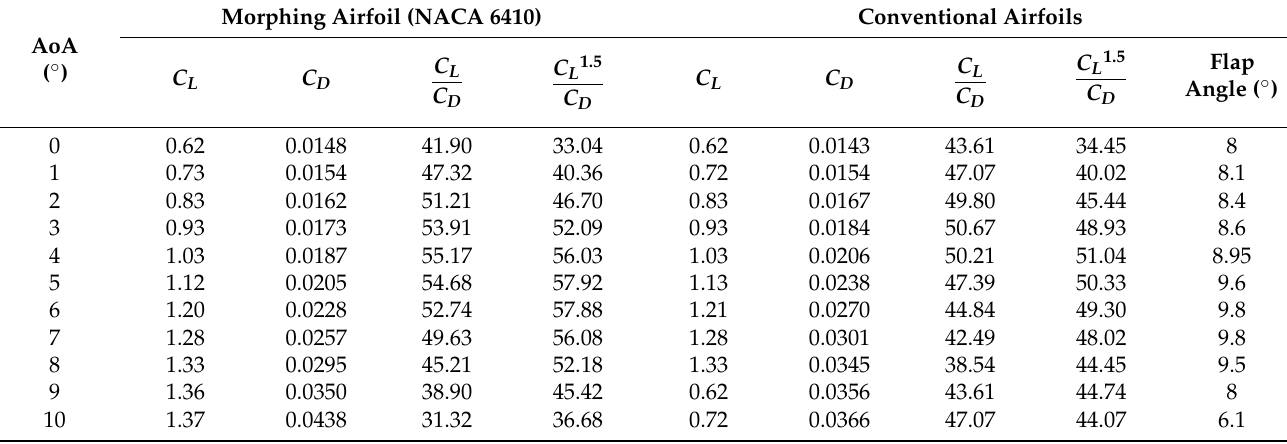
Table 3. Aerodynamic data of morphing (NACA 6410) and matching C (cid:3013) conventional airfoils.